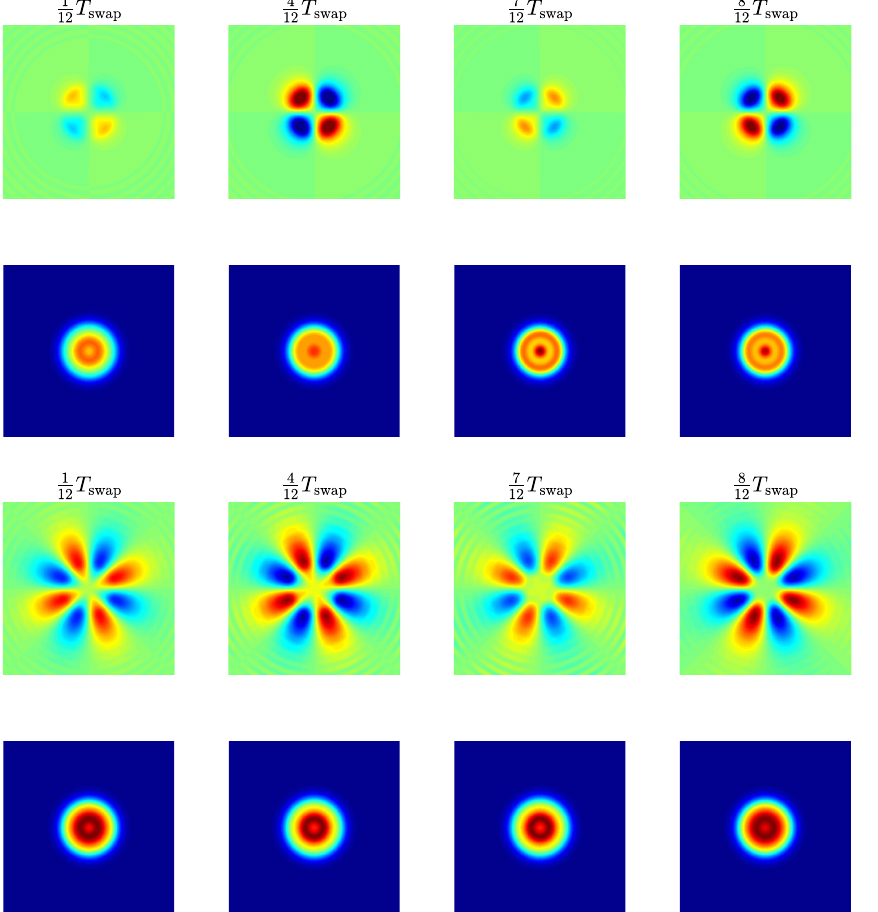
Figure 23. Evolution sequences of the charge and energy density of a quadrupole and octupole CSQs in 2+1D. In the first and third rows, the red color depicts positive charges and the blue color depicts negative charges. The corresponding energy density sequences are displayed in the second and fourth rows, with the blue depicting lower density and the red depicting higher